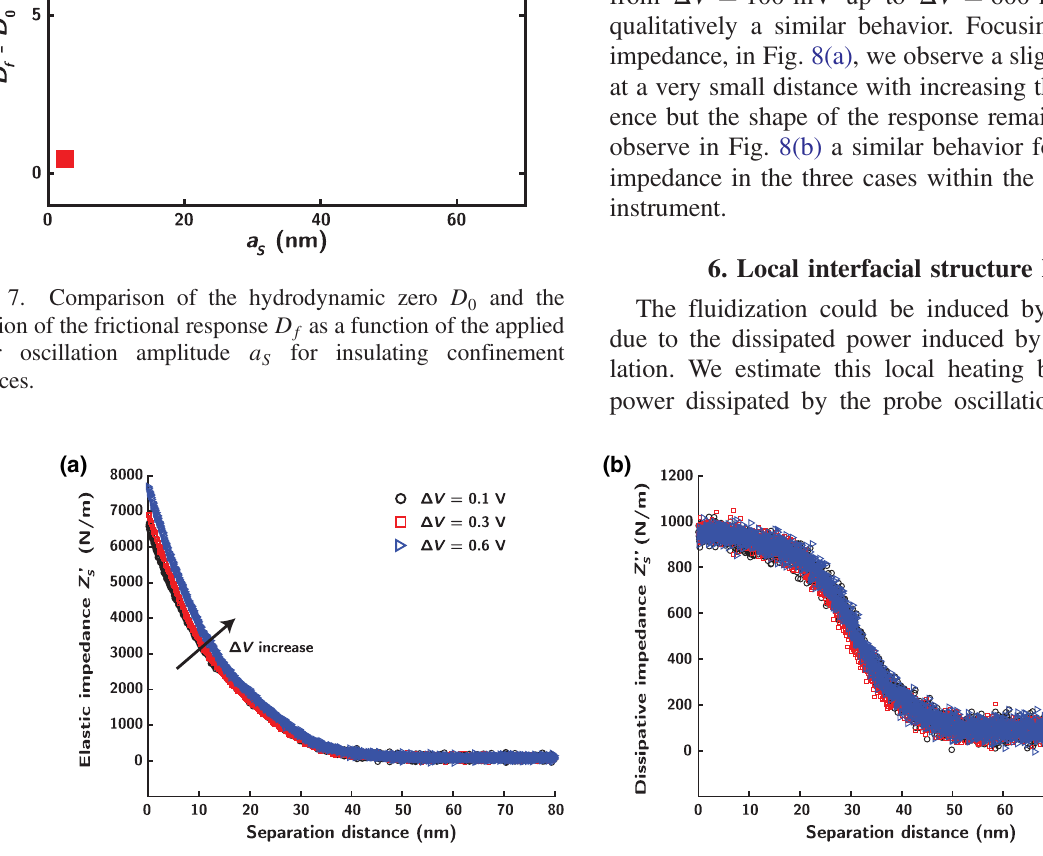
FIG. 8. Shear impedance measurement with different applied voltage difference. Shear amplitude is 5